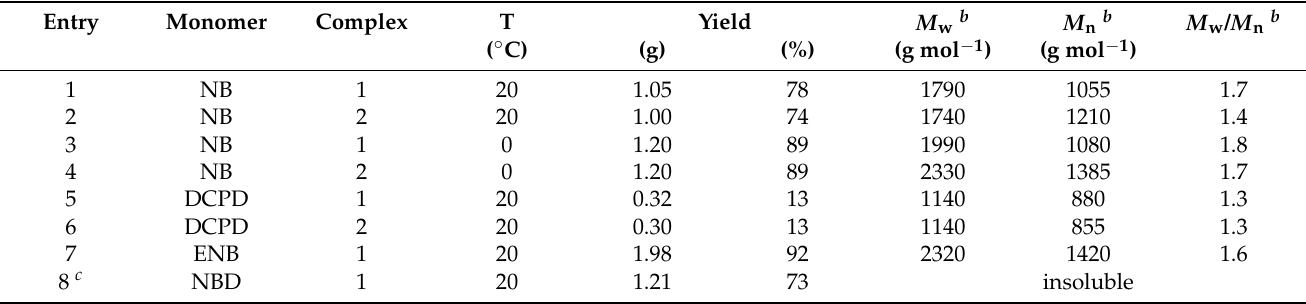
Figure 6. Cyclic olefins employed as monomers in this study. Table 1. Polymerization of NB, DCPD, ENB, NBD promoted by 1 – 2 precatalysts.